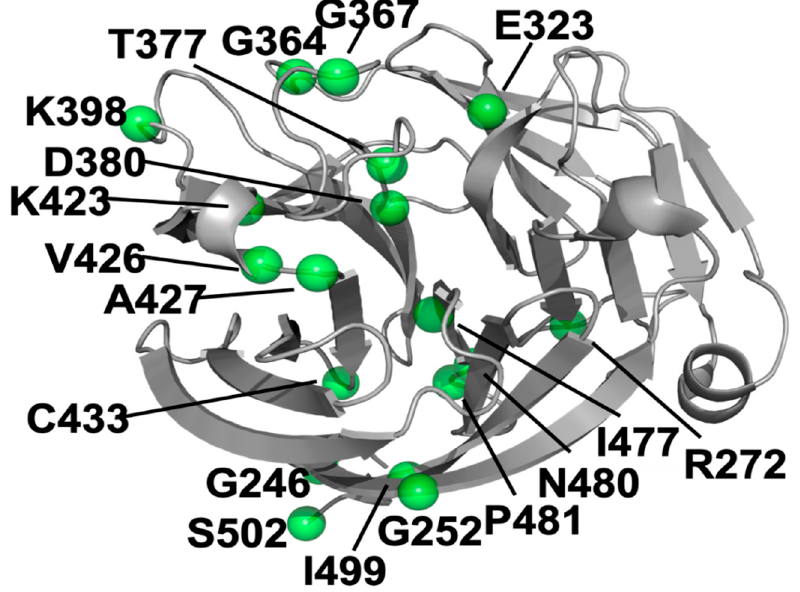
Figure 1. Cartoon structure of the OLF domain of myocilin. The amino acids with known mutations used for statistical analysis are shown as green balls.